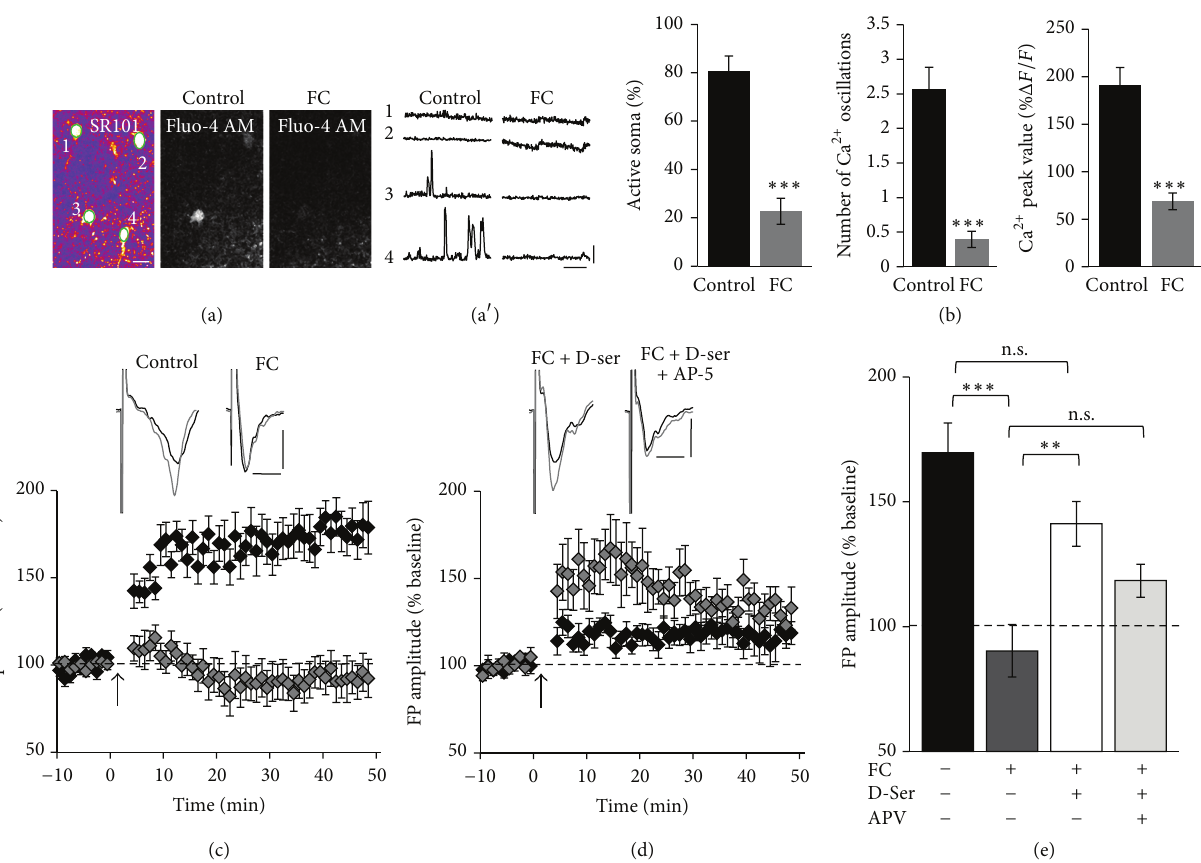
Figure 3: Fluorocitrate blocks astrocytic Ca 2+ transients and LTP in slices. (a) Dual loading of acute M1 slices with SR101 (left) and fluo-4 AM (right) in control and after perfusion of FC. ROIs of astrocyte soma are outlined and numbered. Time-lapse images of the fluo-4 channel for control and after FC conditions. Scale bar: 10 𝜇 m. (a 󸀠 ) Spontaneous Ca 2+ transients in soma in control and FC conditions. Scale bar: 75 s, 100% Δ𝐹/𝐹 . (b) The percent of active soma, the number of Ca 2+ transients, and the peak value of the Ca 2+ transients significantly decreases after treatment with FC. (c) Average time course of the change in FPs in M1 slices after TBS (indicated by arrow) shown for control and FC conditions. Incubation of slices with FC blocks LTP. Representative FPs (average of 5 traces) during baseline condition and 20–30 min after TBS are shown as black and gray traces. Scale bar: 0.4mV, 4ms. (d) Average time course of the change in FPs shown for FC coapplied with D-serine, FC coapplied with D-serine and D-AP5. D-Serine partially rescues LTP. (e) Summary of LTP experiments with FPs measured 20–30 min after TBS relative to baseline. ∗∗ 𝑃 < 0.01 and ∗∗∗ 𝑃 < 0.0001 . mice; 𝑃 = 0.68 , Figure 2(c)) or dendrite width (saline: 0.81 ± administered (day 7: success rate of 0.52 ± 0.06 , day 5 versus 0.02 𝜇 m; FC: 0.83±0.03 𝜇 m; 𝑃 = 0.57 ) in the apical tufts (layer day 7 𝑡 -test, 𝑃 = 0.191 ). These results indicate that 1) of layer 5 pyramidal neurons in the forelimb M1 region.